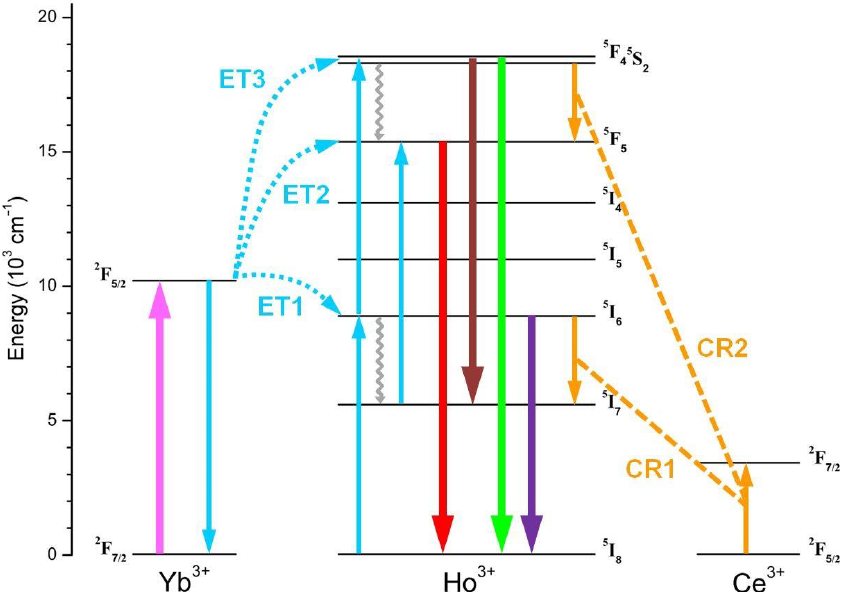
Figure 3. Scheme of the energy level diagram representing UC and transition mechanisms originating the PL emissions observed for the Ln 3+ -doped NaBiF 4 samples. The pink upward arrow refers to Yb 3+ ground-state absorption process (GSA); thick downward arrows refer to Ho 3+ radiative relaxations, where the attributed colors refer to emissions in the red, green and NIR spectral ranges; cyan and orange arrows refer to Yb 3+ -Ho 3+ energy transfer (ET1, ET2, ET3) and Ce 3+ -mediated cross-relaxation (CR1, CR2) processes; grey wavelike arrows refer to multiphonon relaxations.